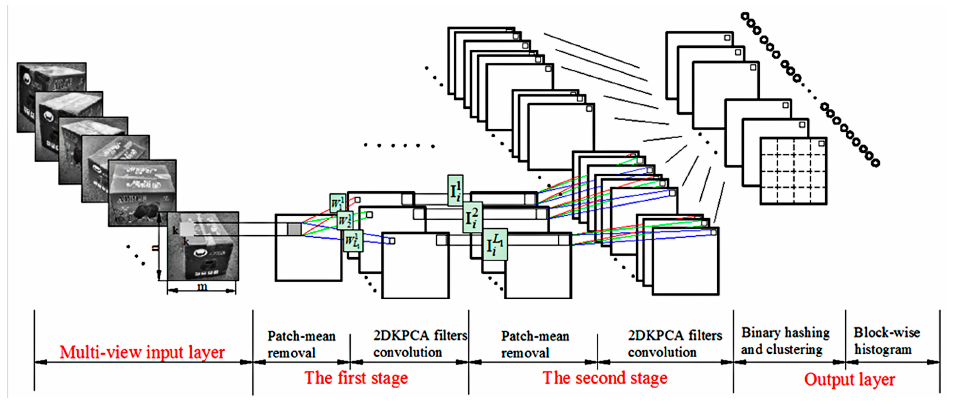
Figure 1. BM2DKPCANet model.